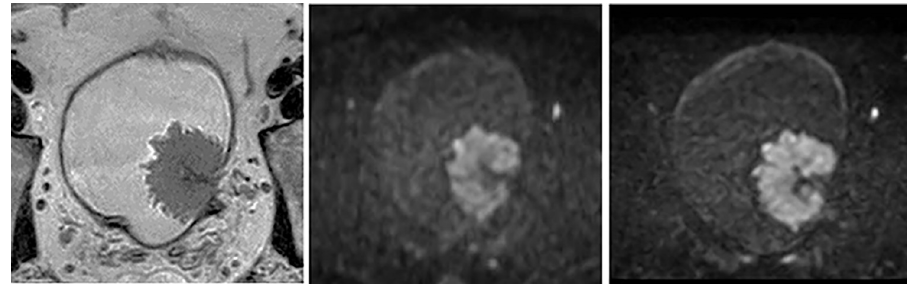
Fig 5. 83-year-old woman with the urothelial carcinoma of pT1 on the left lateral wall of the bladder. (A) T2WI (B) fFOV DWI (C) Zoomed DWI. The tumor appeared as a papillary lesion with tumor stalk in both fFOV and Zoomed DWI, and VI-RADS score was 2 for both